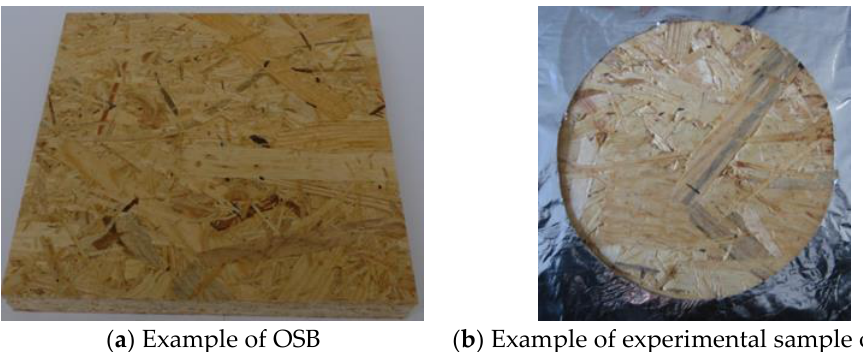
( a ) Example of OSB ( b ) Example of experimental sample of OSB Figure 1. Oriented strand board in ( a ) full piece and ( b ) prepared for measurement according to [24]. Samples of OSB were cut to specific dimensions (165 × 165 mm) according to ISO 5657: 1997 [24]. The density of the strand boards was determined according to Standard EN 323: 1996 [25]. Table 1. Physical and chemical properties and fire technical characteristics of the OSB with thickness of 10–18 mm [13]. Parameters Notes Values